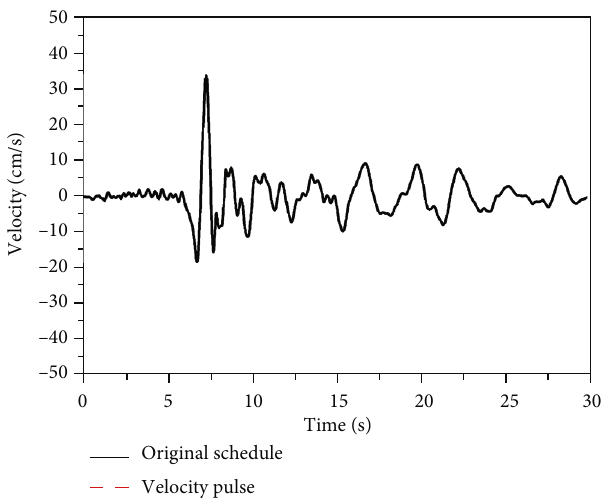
Figure 1: Near-fault velocity pulse extraction results.